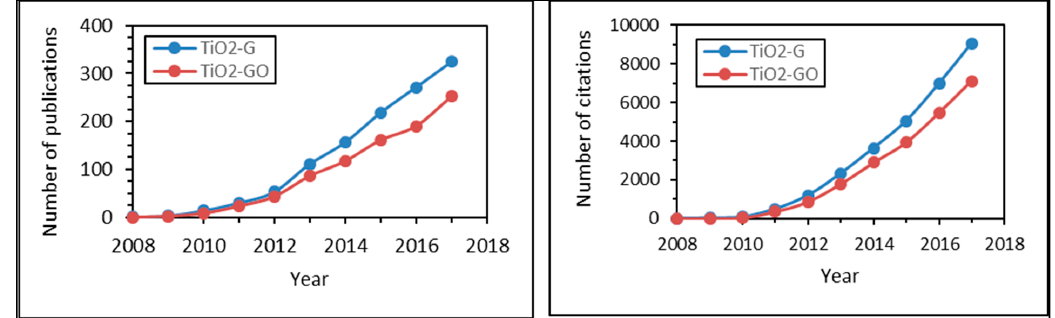
Figure 1. Total number of publications with the keywords “Titanium dioxide and graphene” and “Titanium dioxide and graphene oxide“, based on data from Web of Science database.